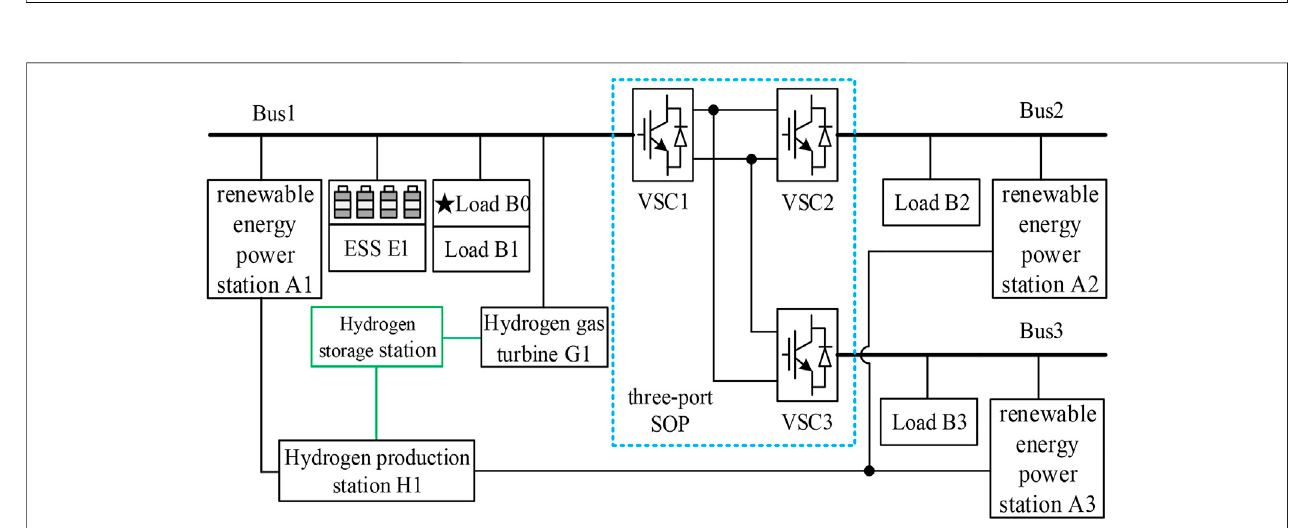
FIGURE 8 | Simulation waveform of the load voltage at the fault side.